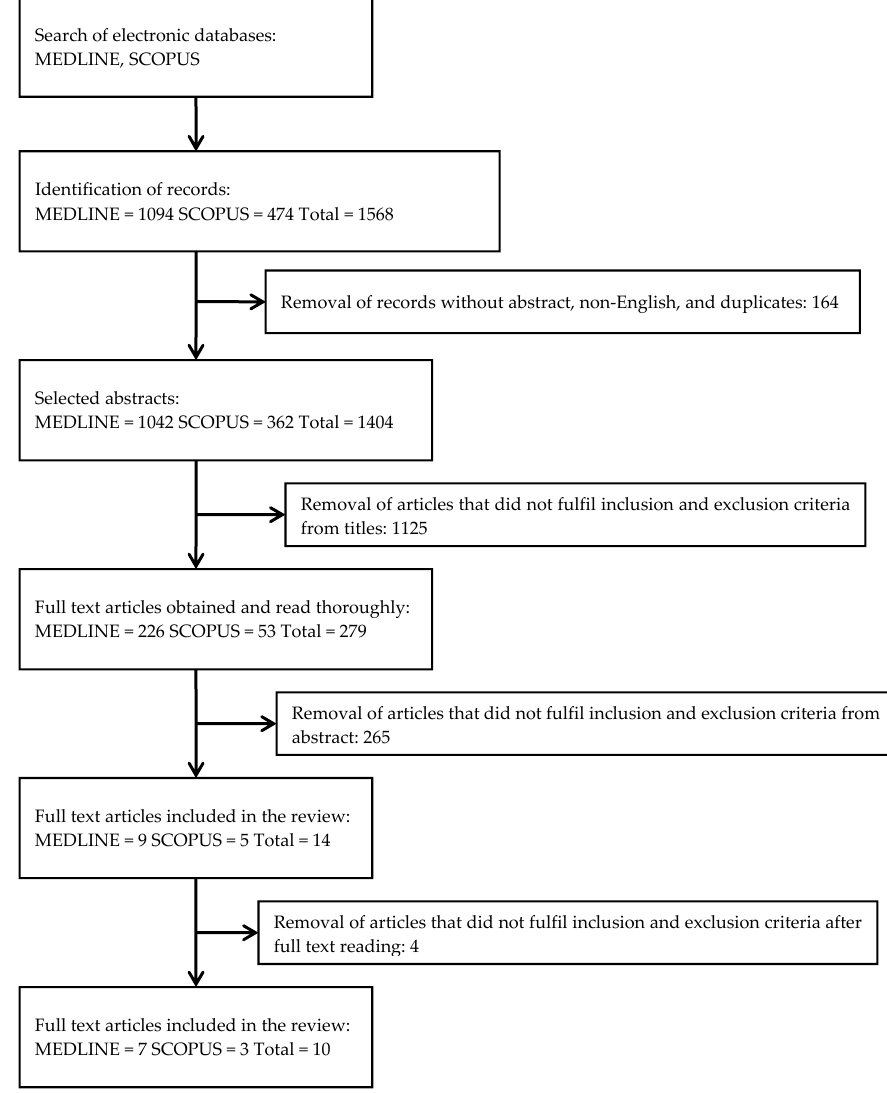
Figure 1. Flowchart of the selection process.